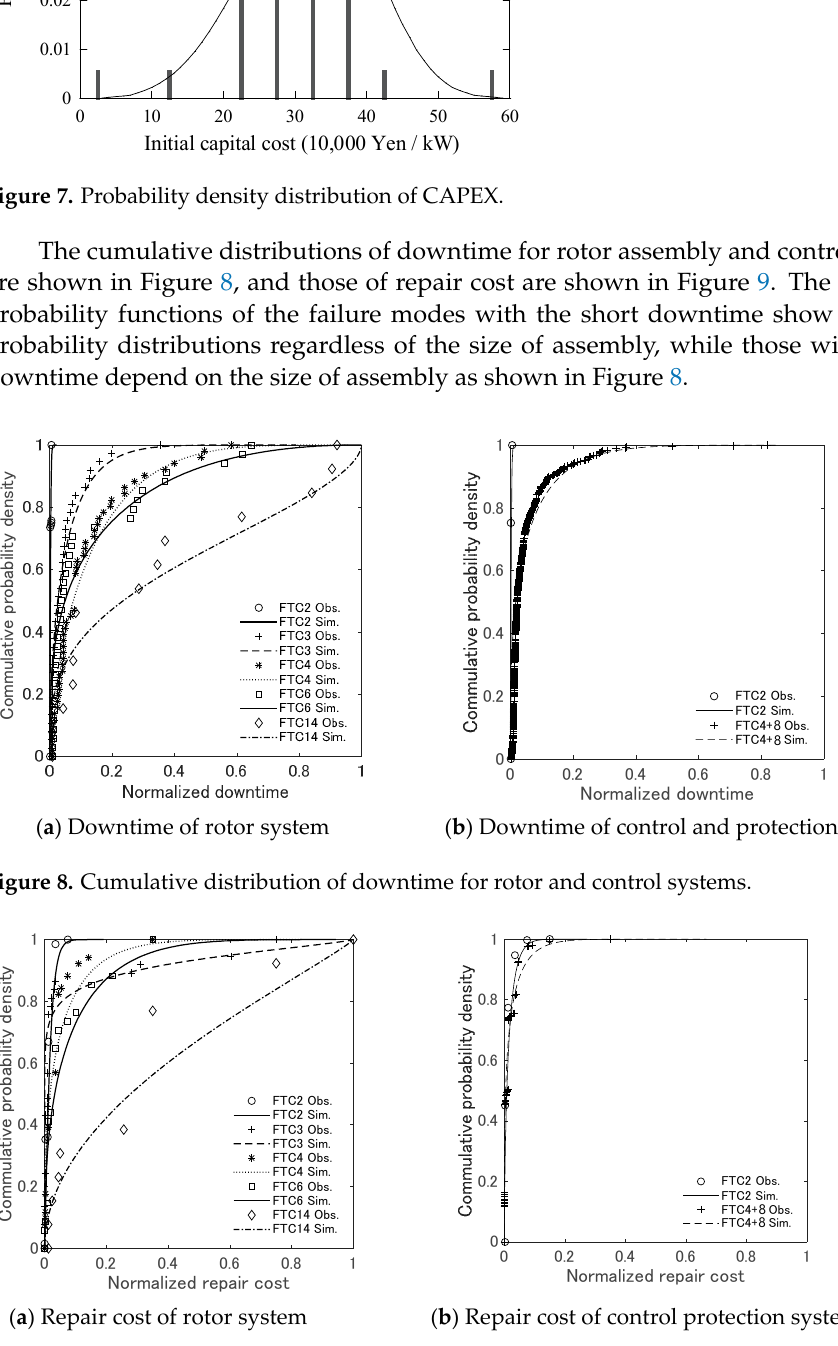
Figure 9. Cumulative distribution of repair cost for rotor and control systems.